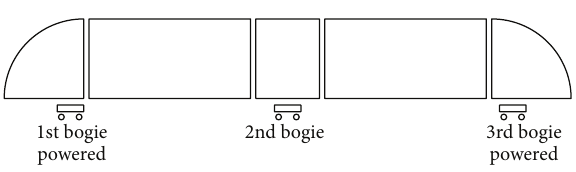
Figure 11: Scheme of the configuration of the tram.